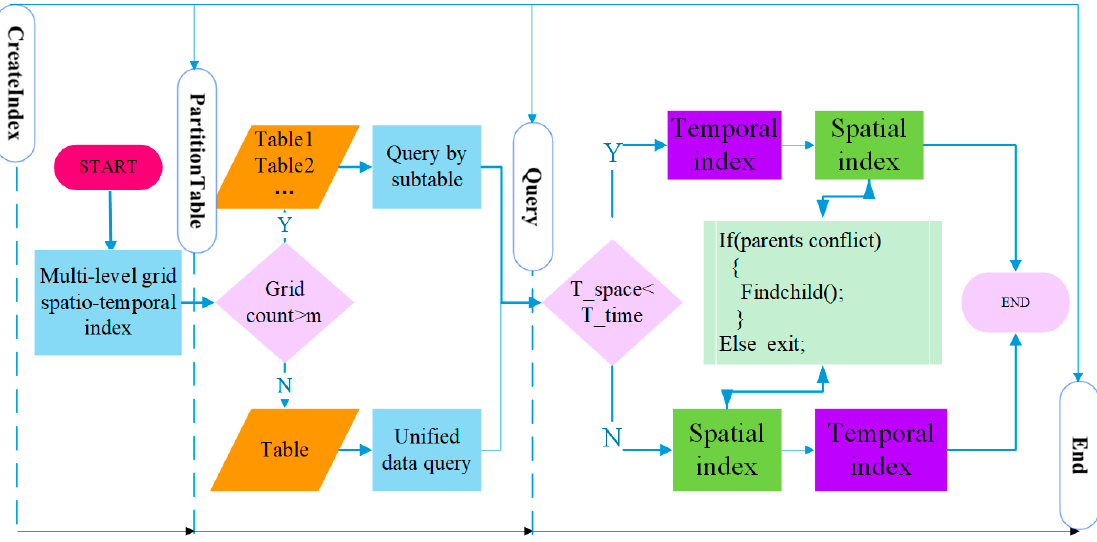
Figure 8. Multilevel grid spatiotemporal index and optimization method.